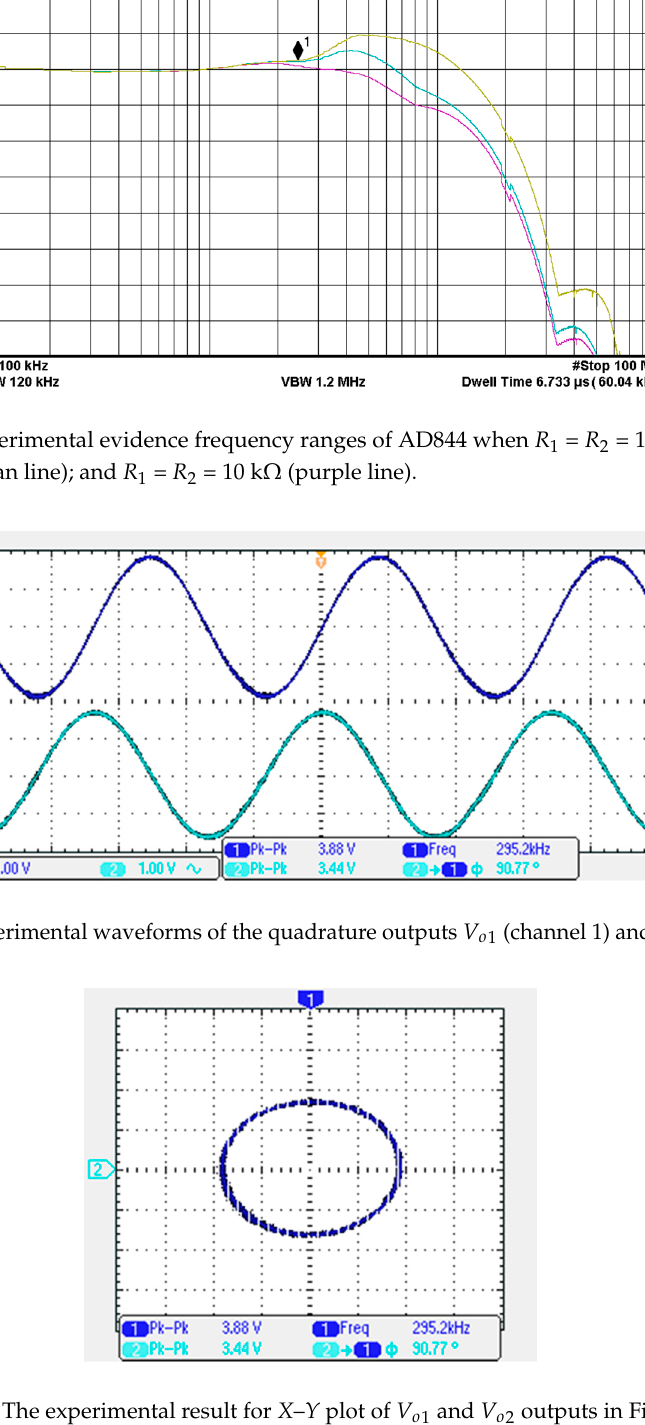
Figure 17. Measured result of operation as an AM signal generator (channel 2) when I B 2 is the applied sinusoidal signal (channel 1). Figure 18. Measured result of operation as an AM signal generator (channel 2) when I B 2 is the applied triangular signal (channel 1).